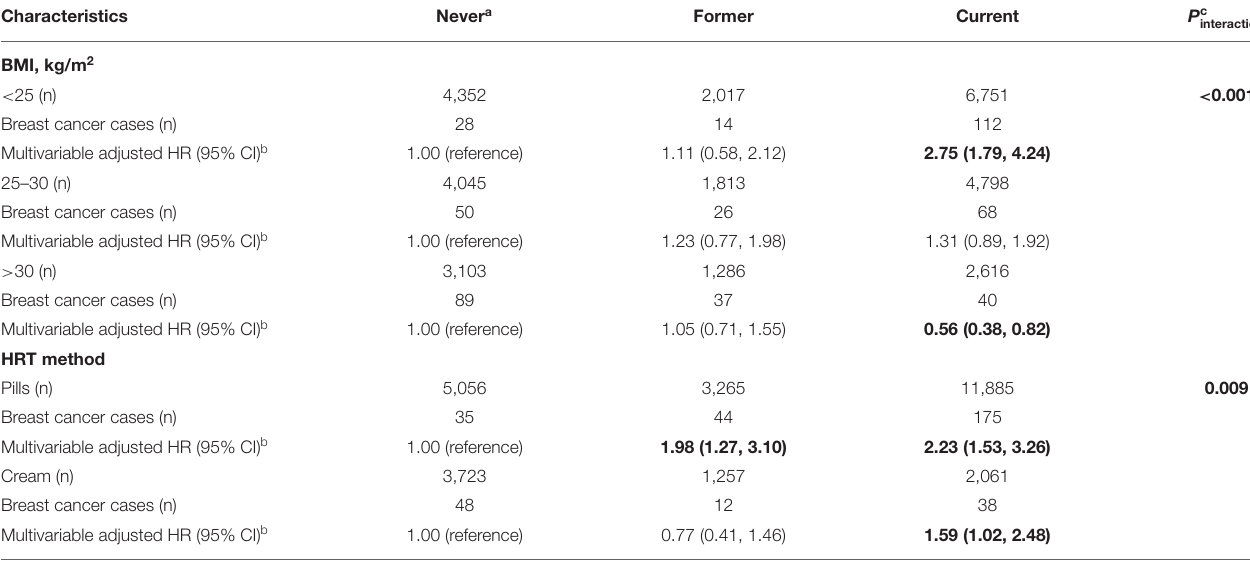
TABLE 3 | Risk of endometrial cancer incidence from estrogen-only use stratified by body mass index, hormone replacement therapy method in the PLCO Cancer Screening Trial: 1993–2009. Characteristics Never a Former Current P c